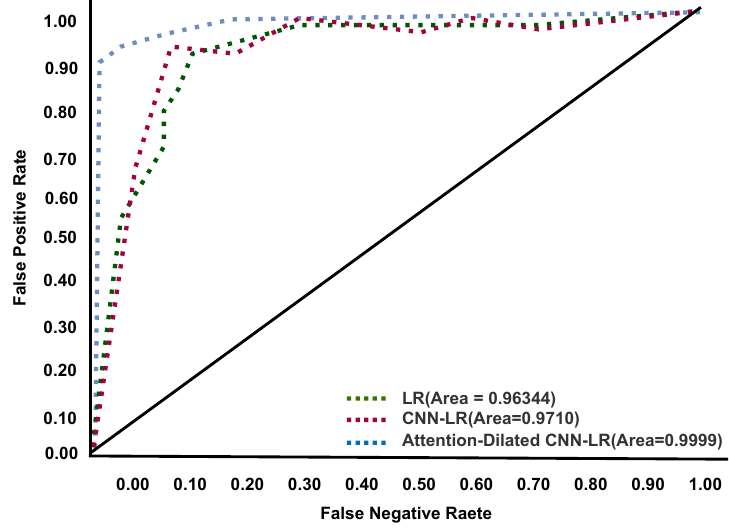
Figure 9. ROC curve during